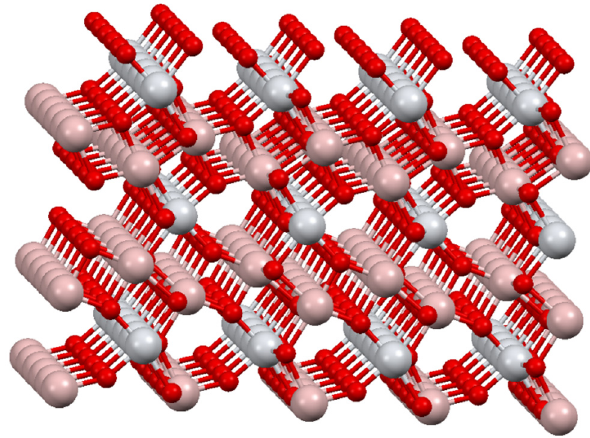
Figure 1. Al 2 TiO 5 (tialite) bulk structure.